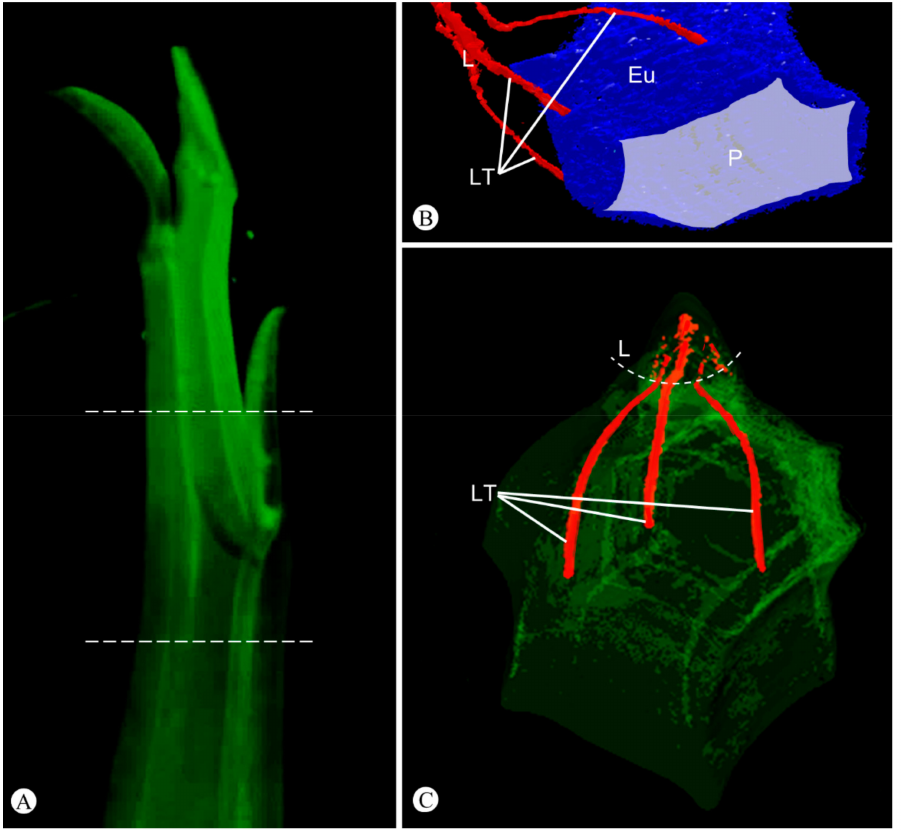
Figure 3. Microtomography with 3D-reconstruction of the shoot of Euphorbia attastoma . ( A ) General view of the shoot. ( B , C ) Reconstructions of the area enclosed by the dashed lines in ( A ). ( B ) Detail of the leaf traces (LT in red) connected to the eustele (Eu in blue) surrounding the medullary parenchyma (P in gray). Note that the three leaf traces do not branch until reach the free portion of the leaf (L). ( C ) Nodal region showing the leaf traces (LT in